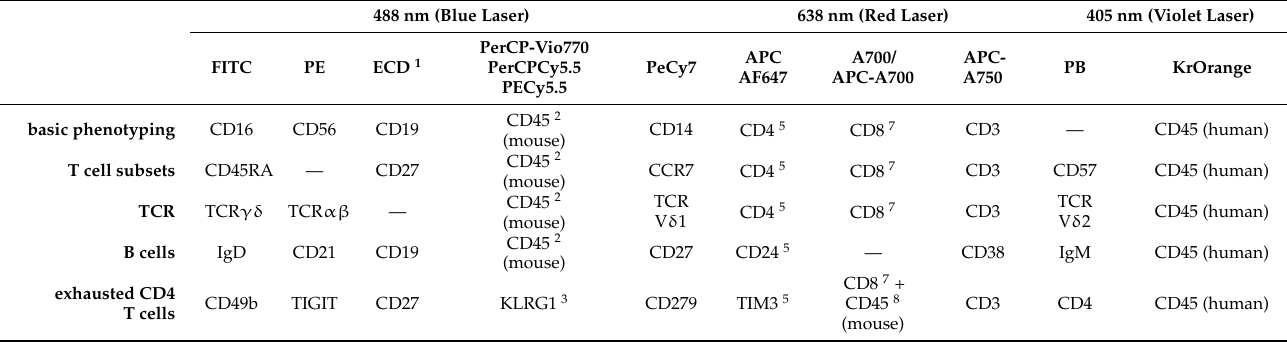
Table 1. Anti-human and anti-mouse antibodies for flow